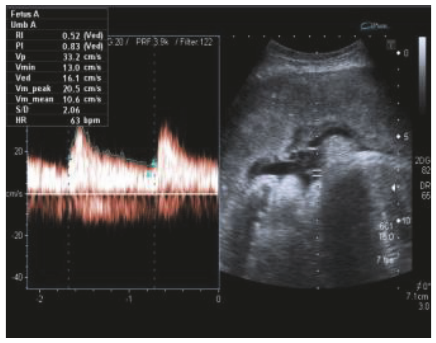
Figure 1: Normal electrical PR (ePR) interval on surface ECG as a guide.